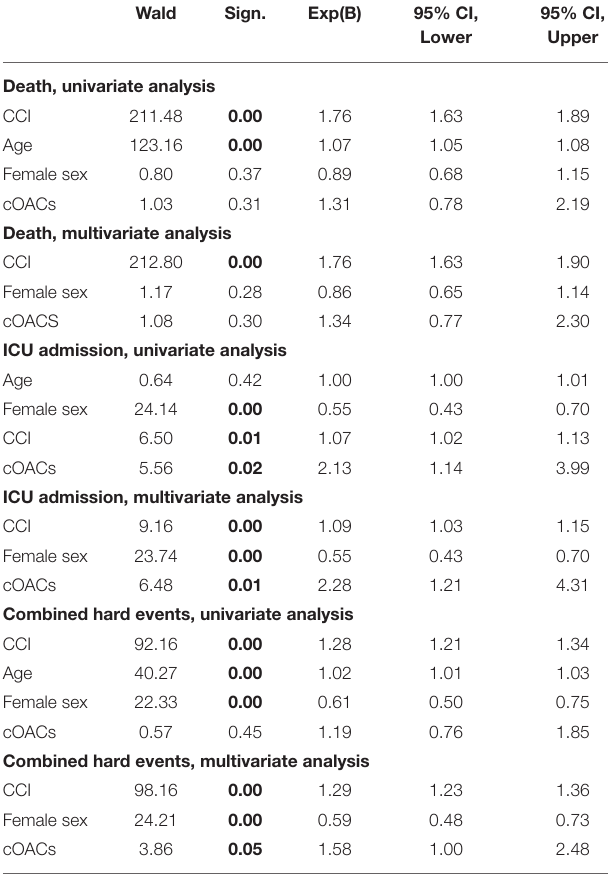
Bold p values indicate statistical